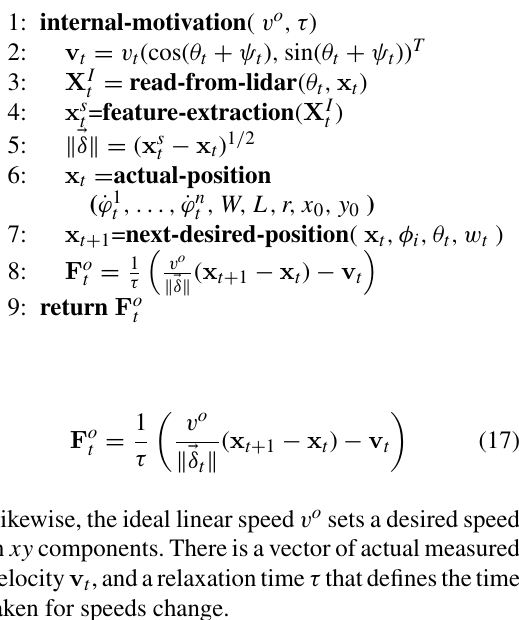
Table 2 Algorithm Directional field for internal